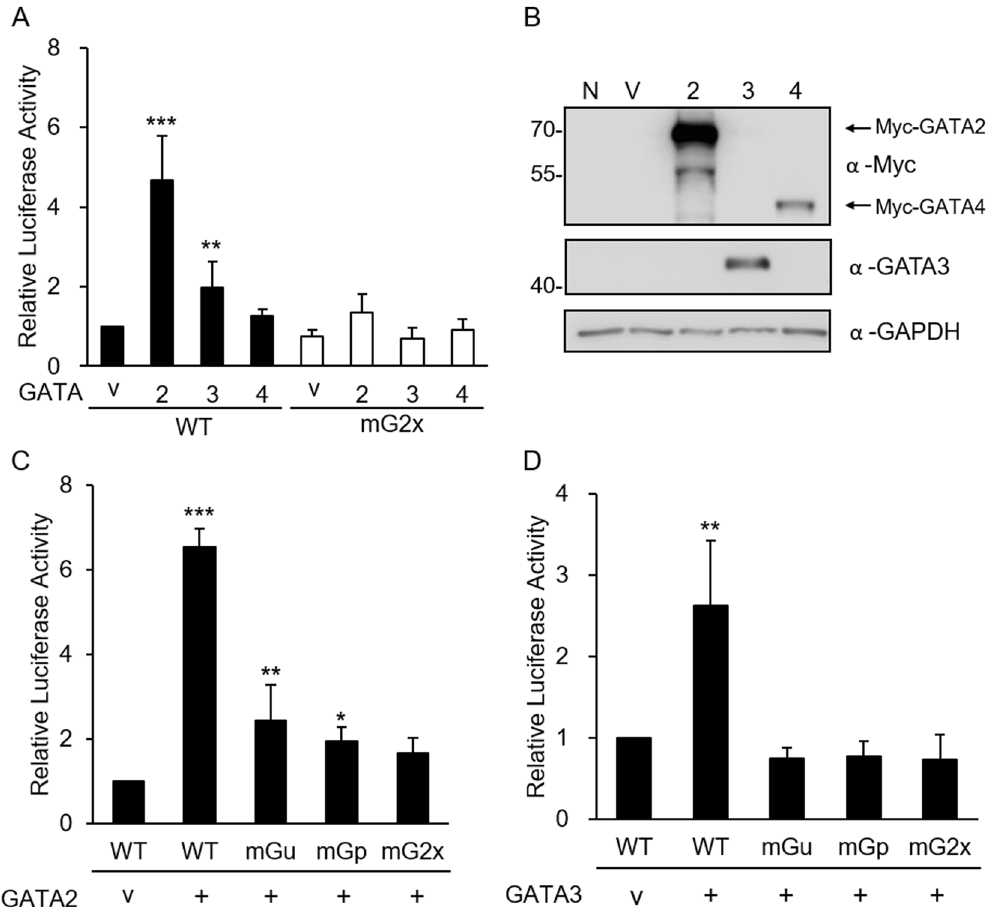
Figure 3. Effects of GATA factors on the transcriptional activity of the HSD3B1 promoter. ( A ) HSD3B1 promoter-luciferase constructs containing wild-type or mutated GATA sites were co-transfected into HeLa cells with the expression vector for GATA2, GATA3, GATA4 or empty vector control (v) as indicated in ( A , C , D ), respectively. Cells were harvested after 24 h of transfection and assayed for luciferase activity. Results are presented as the activity relative to the empty vector. Data are means ± SD of nine ( A ), four ( C ) or five ( D ) independent experiments. * P < 0.05, ** P < 0.01, *** P < 0.001 compared with the vector control. ( B ) Expressions of GATA proteins were detected by western blot analysis with anti-GATA3 and anti-Myc for GATA2 and GATA4. N, non-transfected cells; V, vector control. Uncropped images of blots were shown in Supplementary Fig.